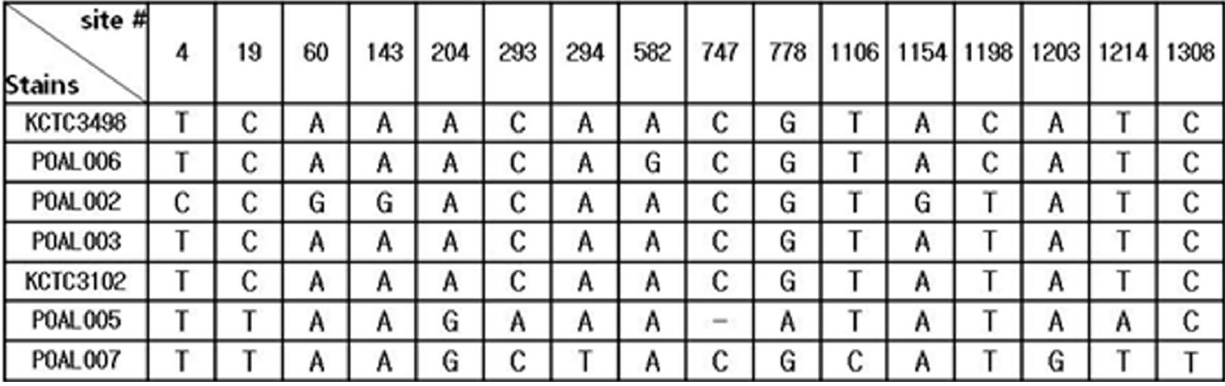
Figure 2. Base changes in the 16S rRNA sequences of L.brevis strains.